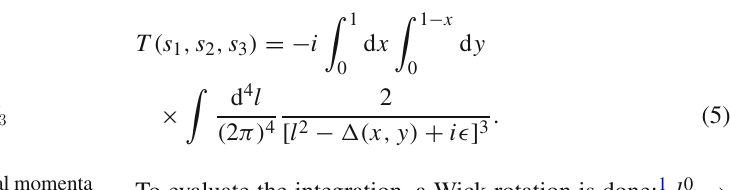
Fig. 1 A general triangle diagram. The external and internal momenta aredenotedas p i and k i ,andtheinternalandexternalmassesarelabeled m i and M i ( i = 1 , 2 , 3),